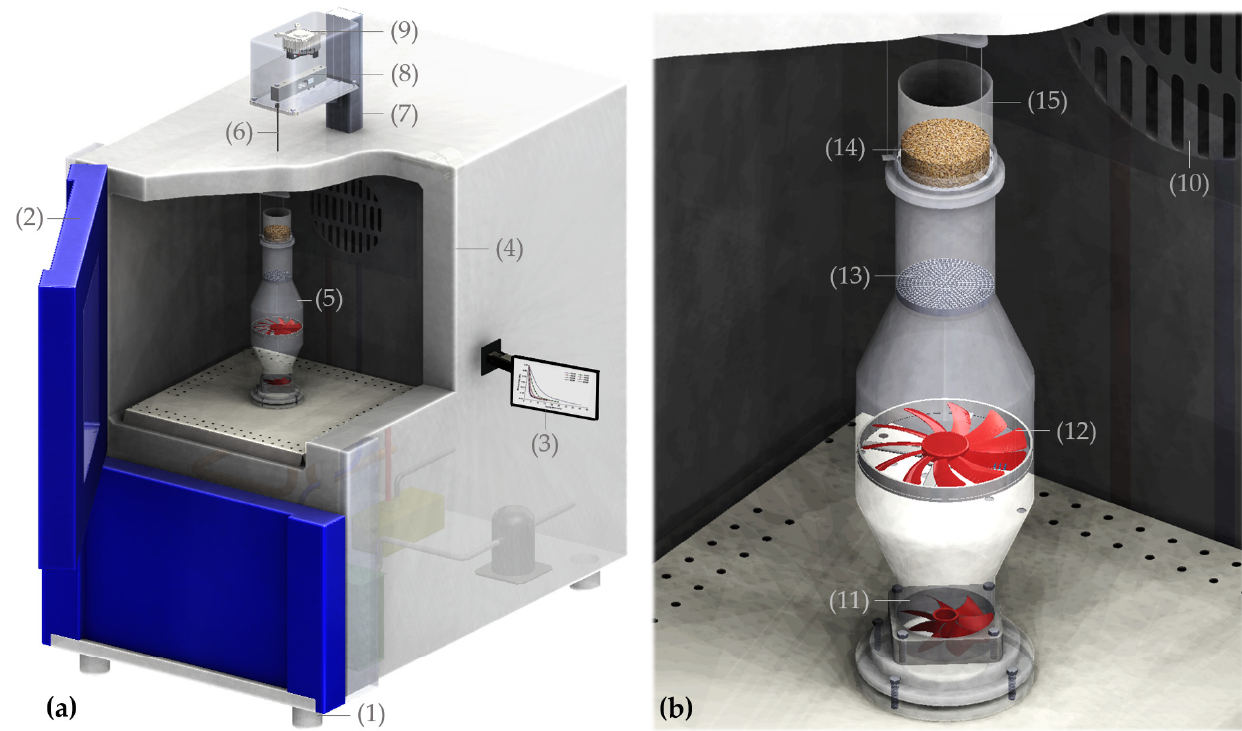
Figure 1. ( a ) Cutaway view of the automated drying system and ( b ) magnified view of the system interior; (1) vibration damping support, (2) mechanical door closer, (3) laboratory computer, (4) climatic test chamber, (5) drying column unit, (6) nylon string, (7) spindle drive, (8) load cell, (9) cooler, (10) air circulation fan, (11) axial fan, (12) vane anemometer, (13) airflow straightener, (14) thin-layer of wheat kernels, (15) acrylic sample